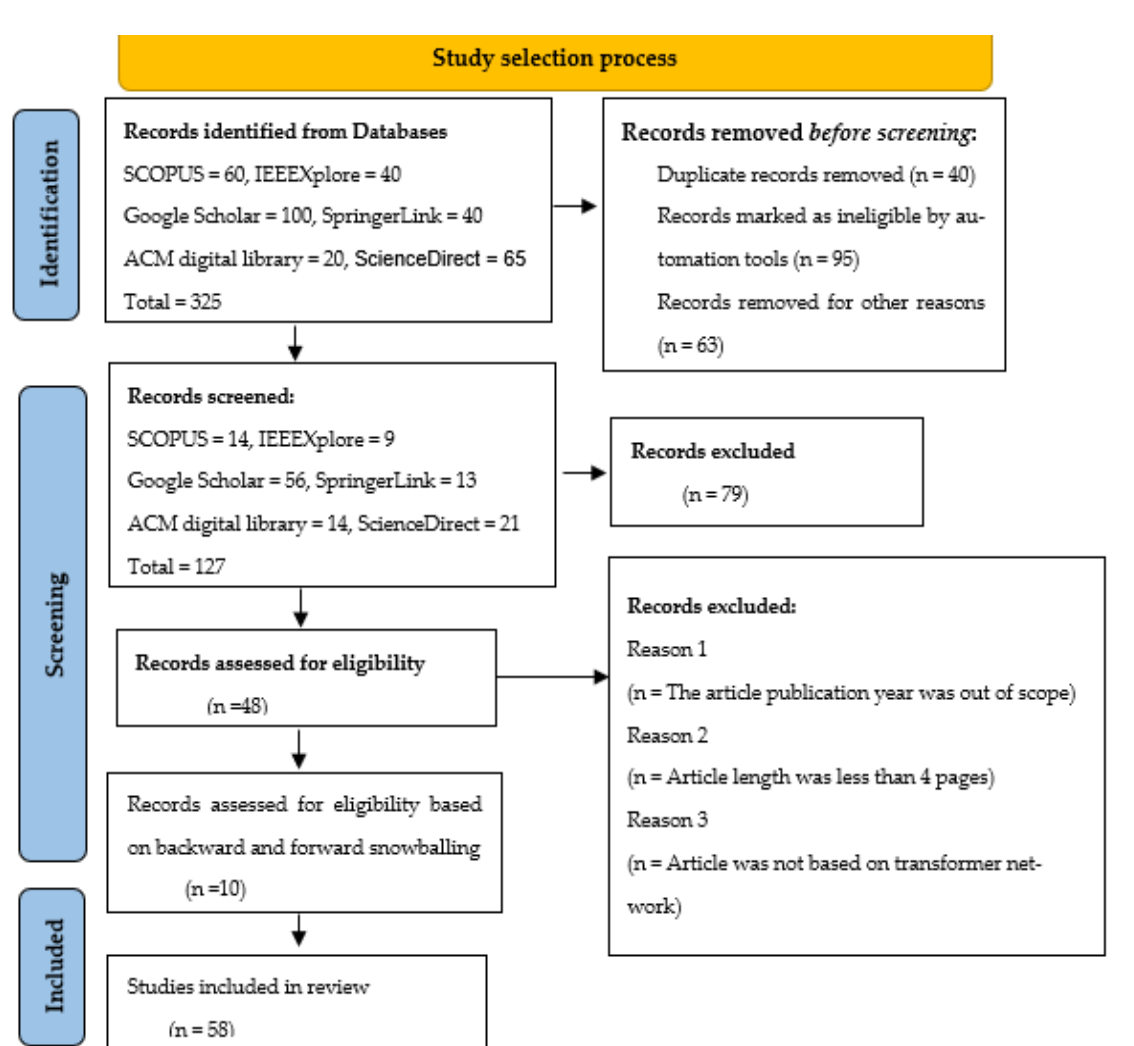
Figure 1. Article retrieval and selection process based on PRISMA reporting standard. The selected 58 publications consist of 26 (46%) conference publications and 32 (54%) journal articles published from 2018 to 2022. A summary of retrieved articles is in Figure 2.